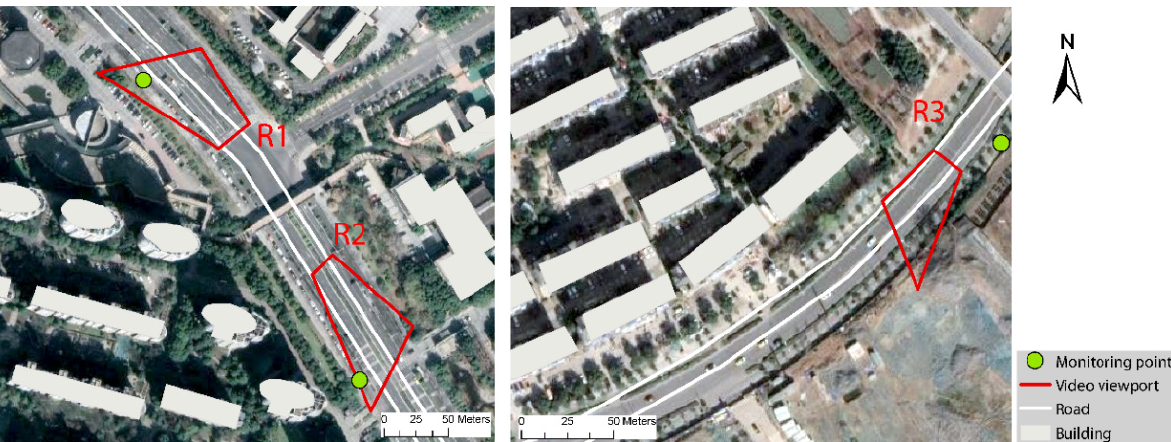
Figure 7. Road network, buildings, video viewport and monitoring point in the experimental area.